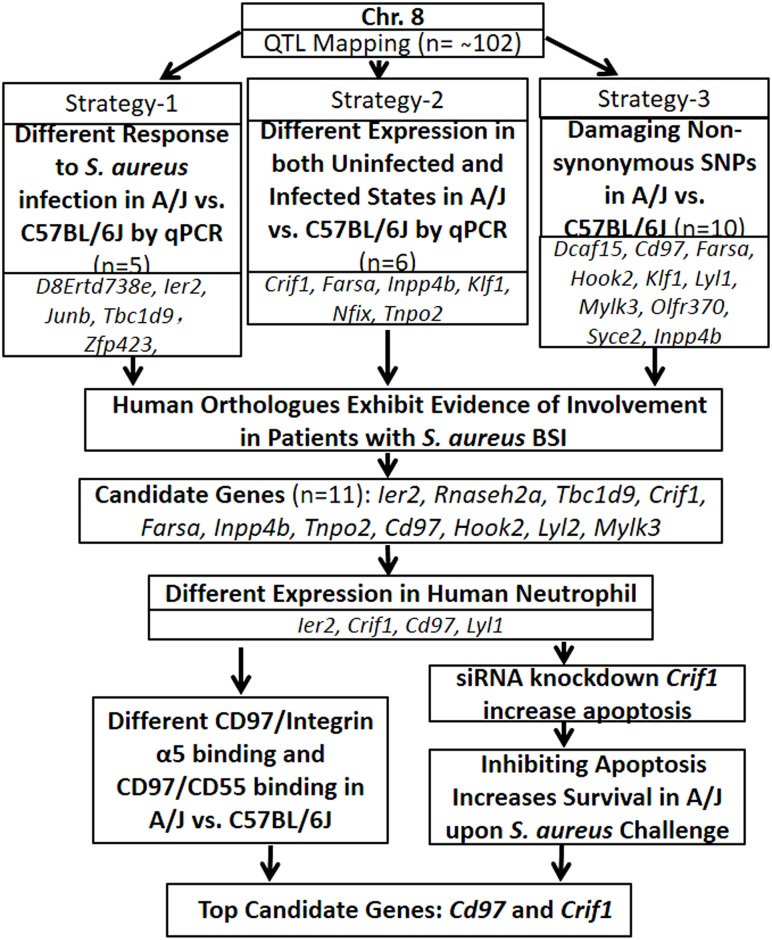
Overall strategies for identifying genes associated with S. aureus susceptibility on chromosome 8 of A/J mice.Flow chart of the strategies for identifying S. aureus susceptible genes on chromosome 8 of A/J mice. Three different strategies were applied. Strategy 1 identified genes within the QTL region that were differentially expressed between A/J and C57BL/6J mice only in the setting of S. aureus infection by microarray and qPCR. Five candidates were identified by Strategy 1: D8Ertd738e, Ier2, Junb, Tbc1d9 and Zfp423. Strategy 2 identified genes within the QTL region that were differentially expressed between A/J and C57BL/6J mice in both uninfected and S. aureus infected states by microarray and qPCR. Six candidates were identified by Strategy 2: Crif1, Farsa, Inpp4b, Klf1, Nfix and Tnpo2. Strategy 3 identified damaging non-synonymous SNPs in A/J vs. C57BL/6J. Ten candidates were identified by Strategy 3: Dcaf15, Cd97, Farsa, Hook2, Klf1, Lyl1, Mylk3, Olfr370, Syce2 and Inpp4b.